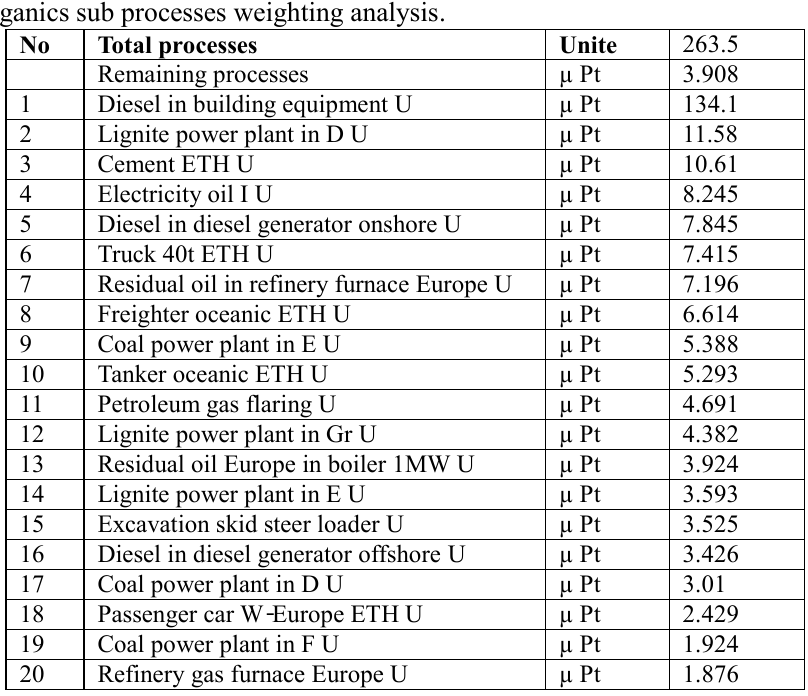
Table 4 Respiratory inorganics sub processes weighting